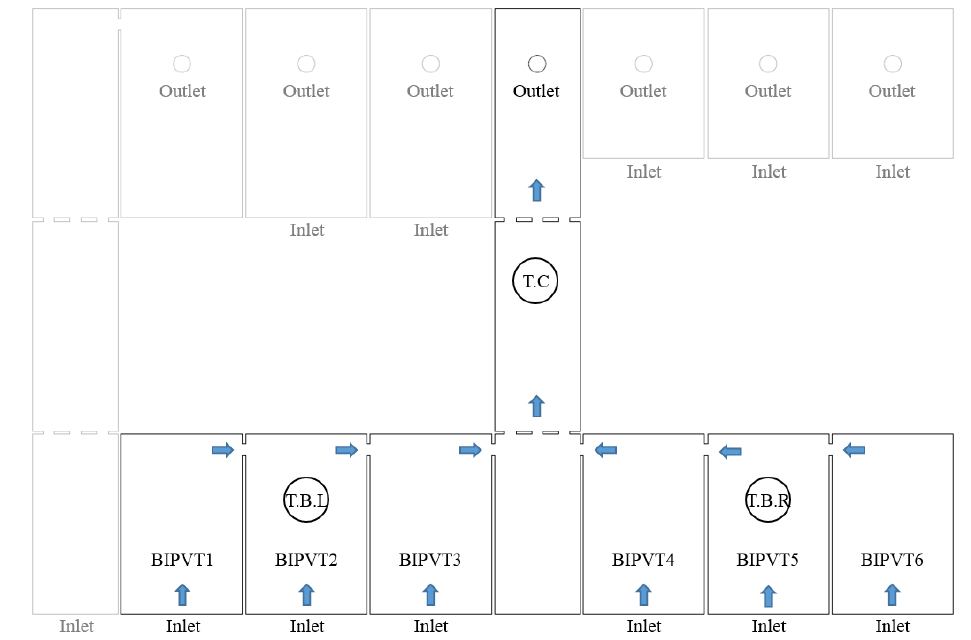
Figure 6. Air-type BIPVT collector connection air flow concept. Table 1. Inlet open rate of air-type BIPVT